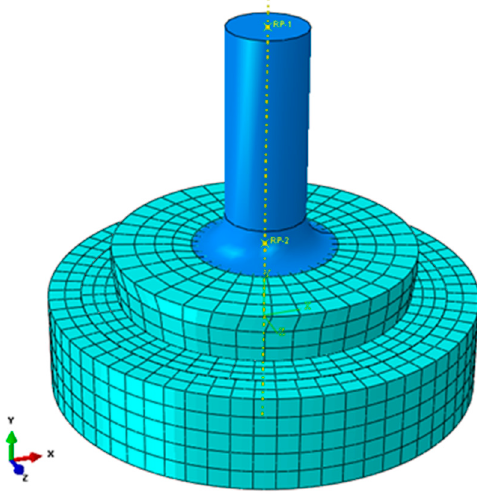
Figure 14. Discrete model of the test rig.